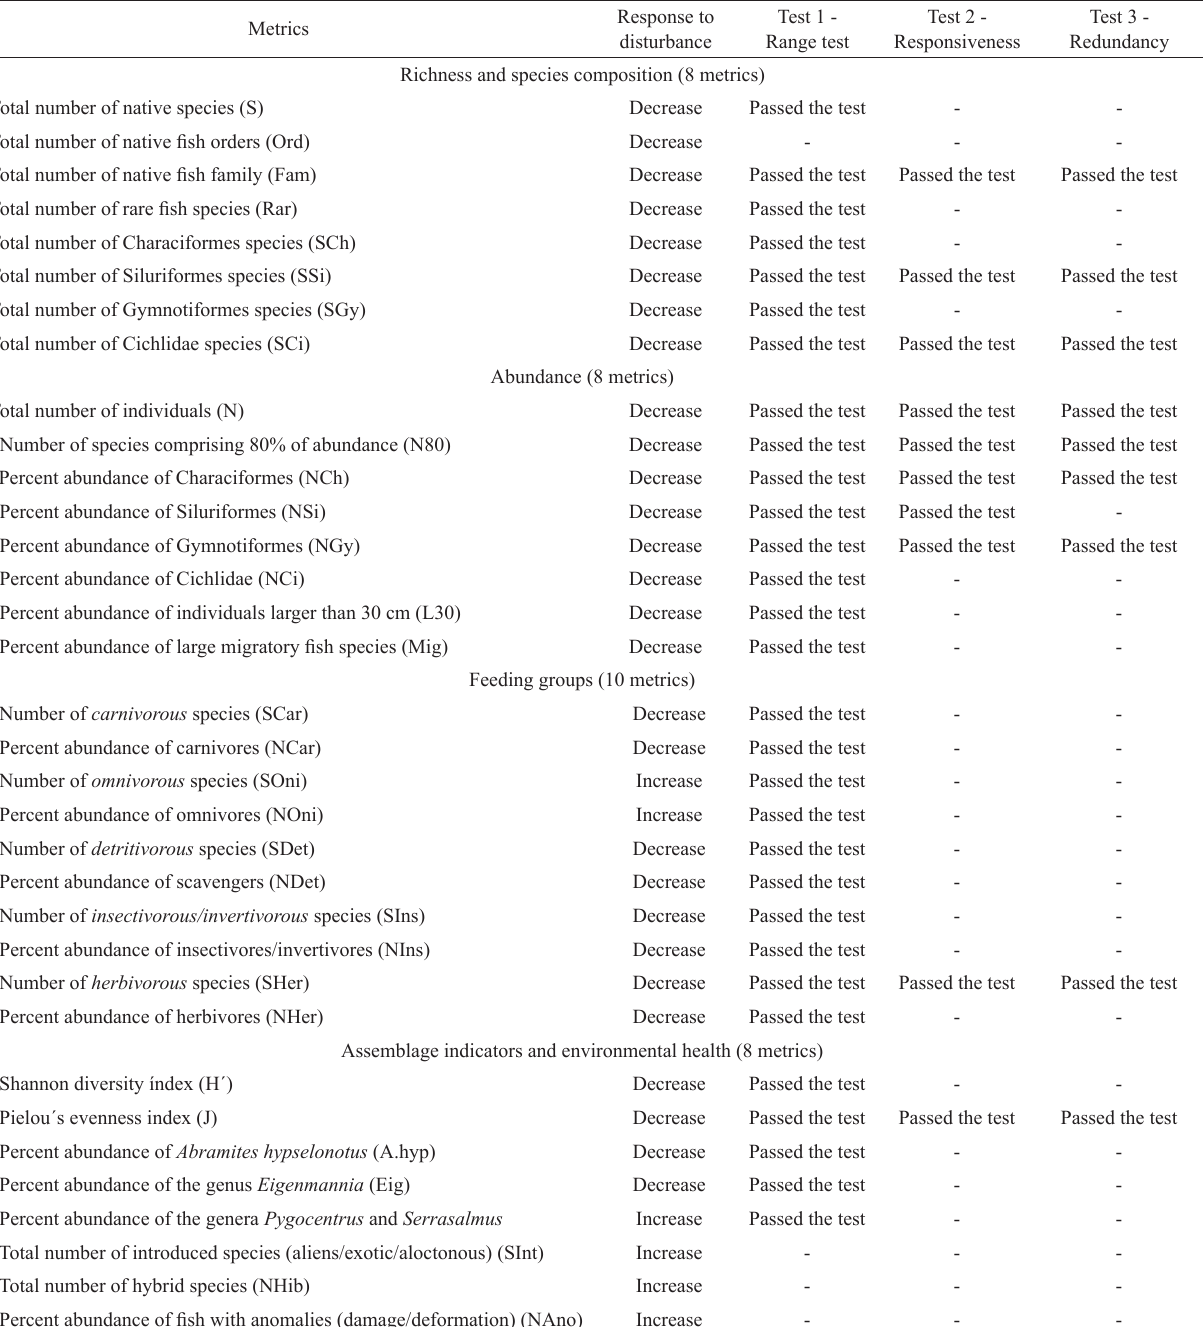
Tab. 1. Candidate metrics, expected responses to disturbance and results of criteria tests (1, 2 and 3) to compose the IBI The sign (-) indicates that the measure did not pass the